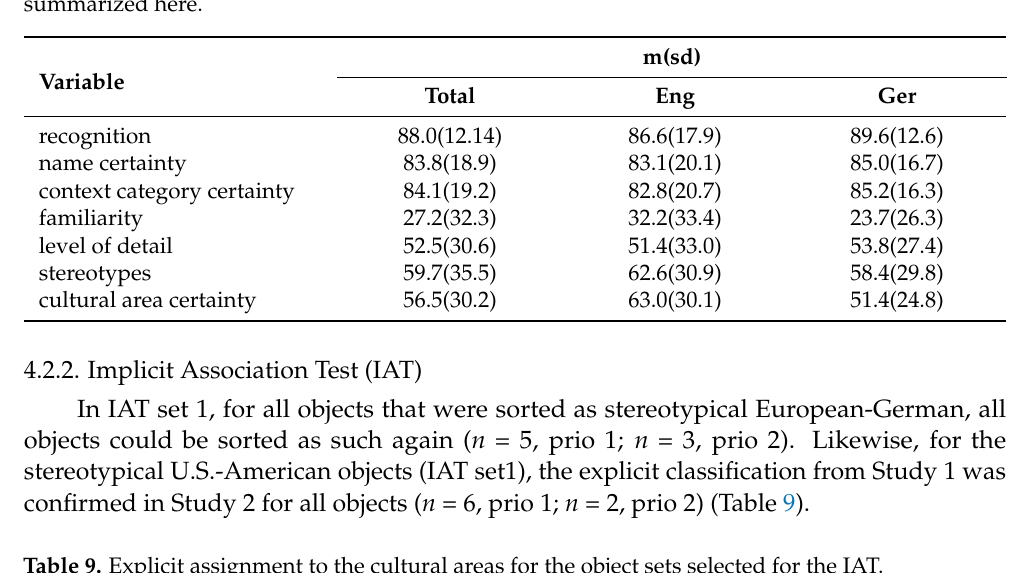
Table 9. Explicit assignment to the cultural areas for the object sets selected for the IAT.